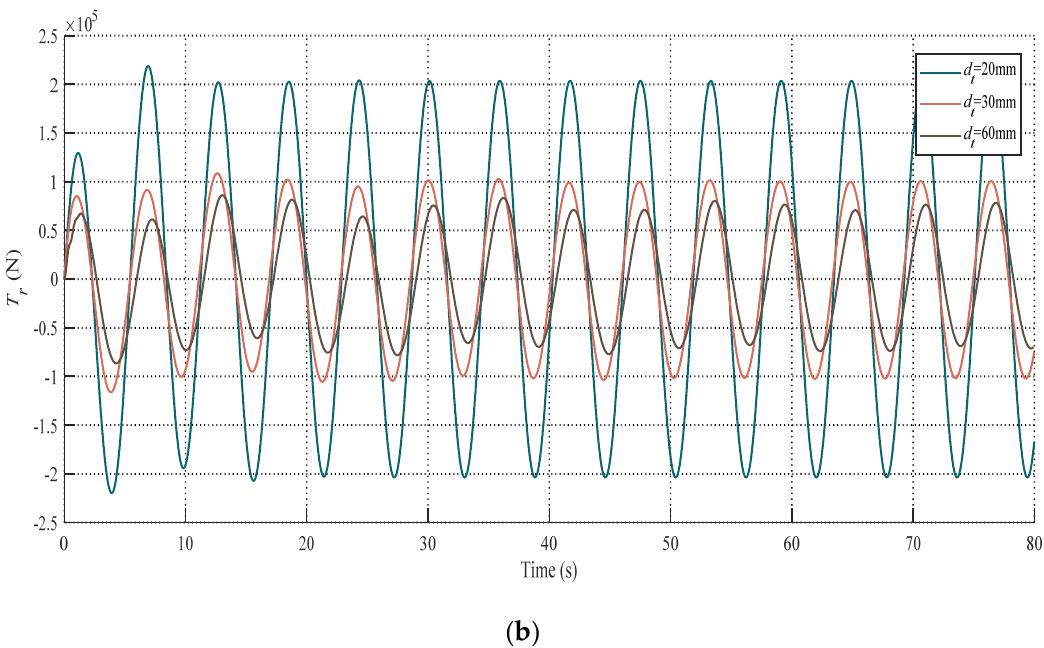
Figure 11. Responses of the compensator with different d t .